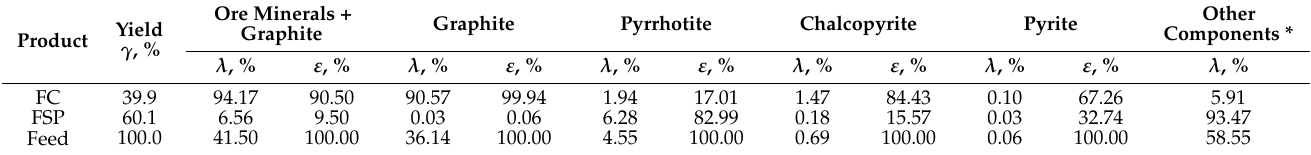
Table 5. The balance of cleaning flotation—analysis of the flotation of the major